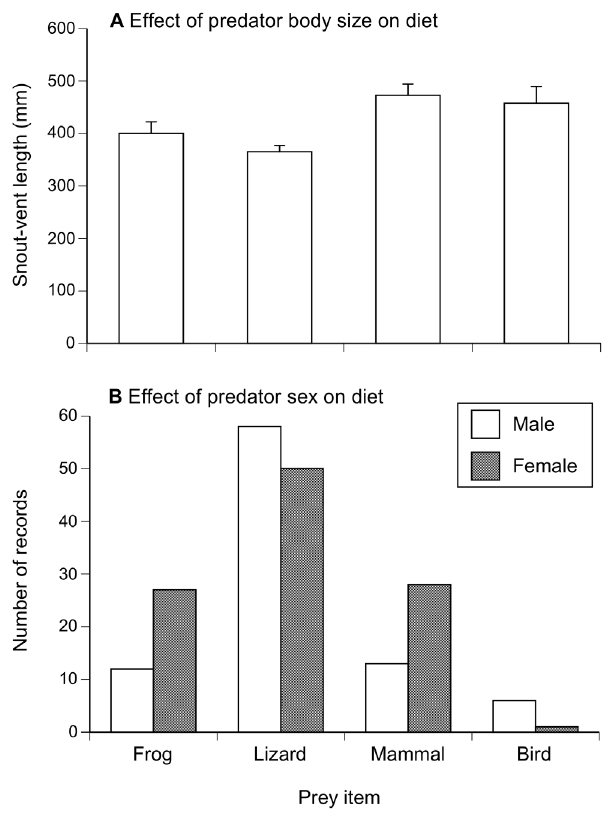
Figure 6. Influence of size and sex on prey consumption in Acanthophis . Panels show the effects of (A) body size and (B) sex on the prey types consumed by death adders. Graphs show mean values and associated standard